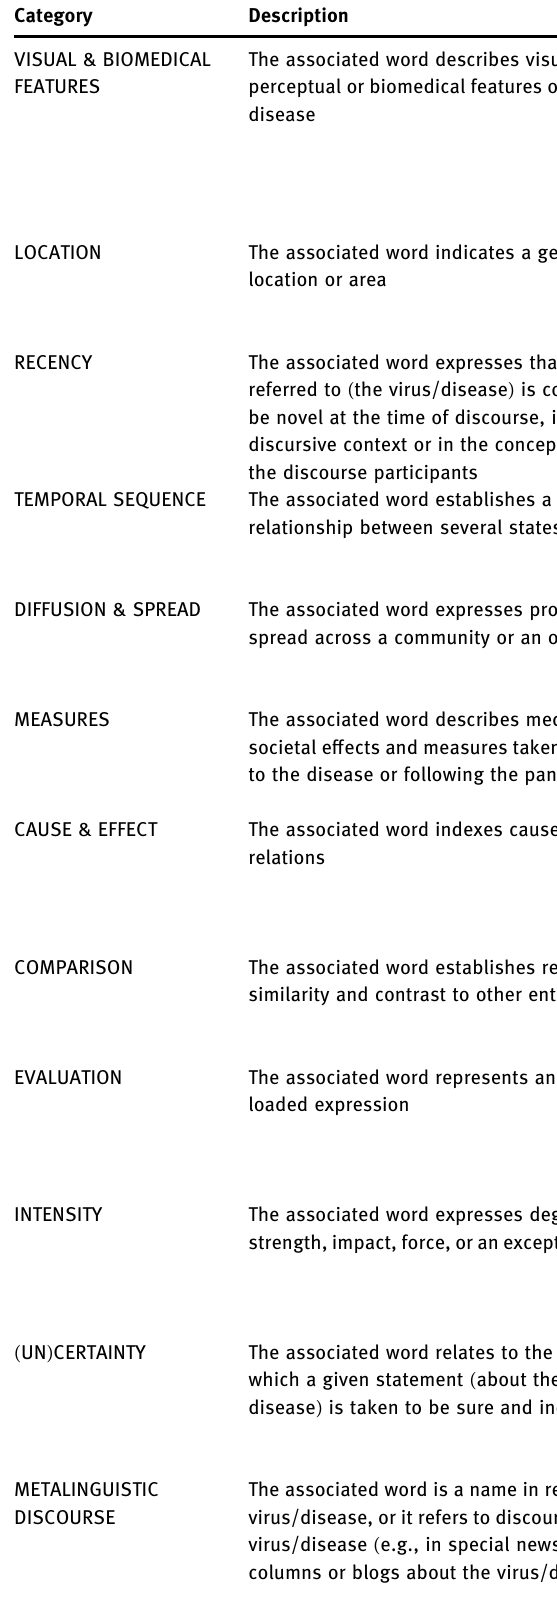
Table 3: Overview of the semantic categories emerging from the data, including their de fi nitions and examples for each